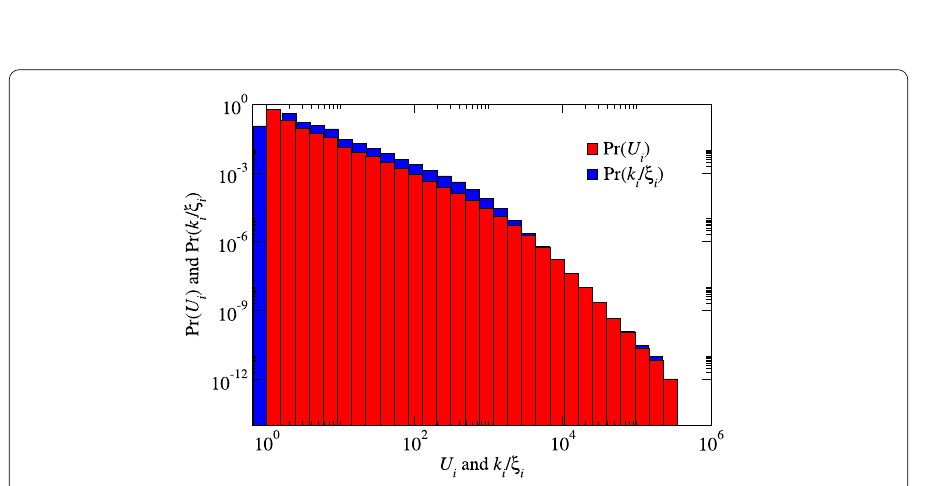
Figure 9 Probability distributions of U i (red) and k i / ξ i (blue) for Mexico binned logarithmically with 30 bins for the range of values of both sets. For most of the range of U i and k i / ξ i , the two distributions are almost parallel